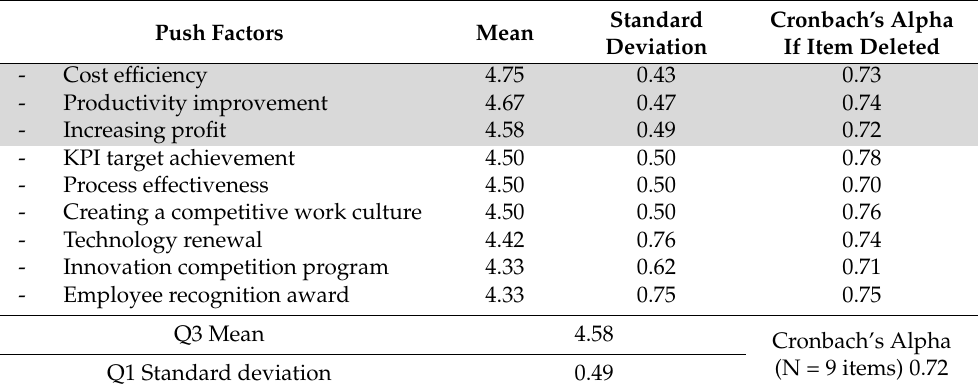
Table 12. Calculation of Q3 mean and Q1 standard deviation of push